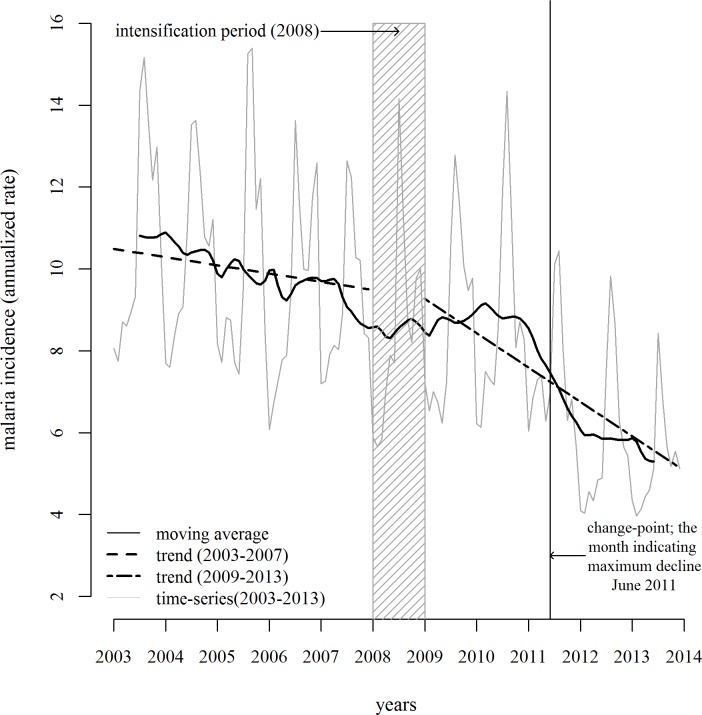
Malaria incidence during 2003–2007 and 2009–2013, Odisha.